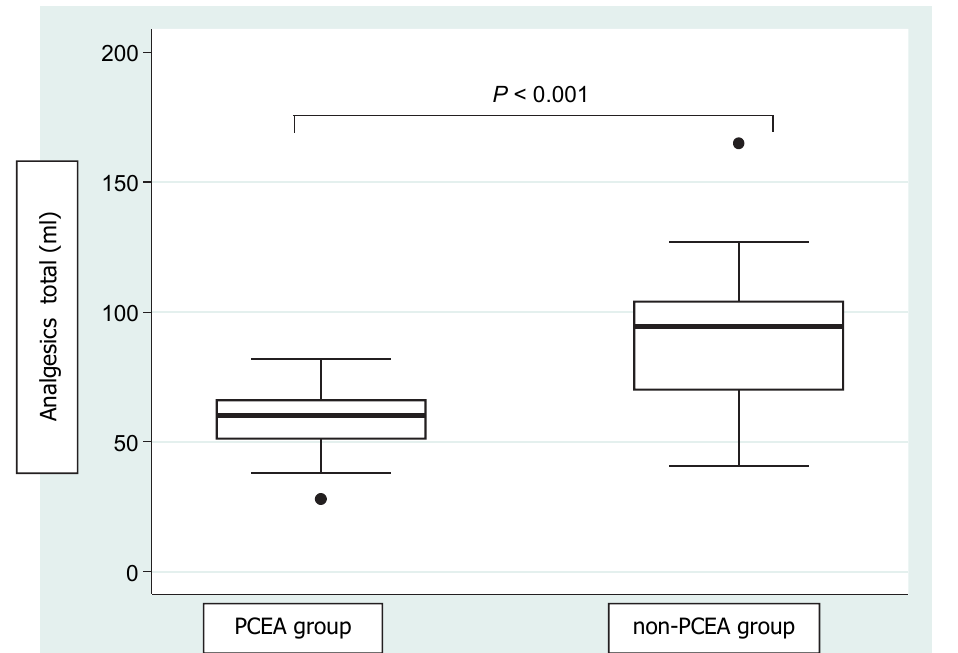
Fig. 2. Comparison of the total use of the analgesic mixture between the PCEA and non-PCEA group. PCEA, patient-controlled epidural analgesia; non-PCEA, (conventional) non-patient-controlled epi- dural group.